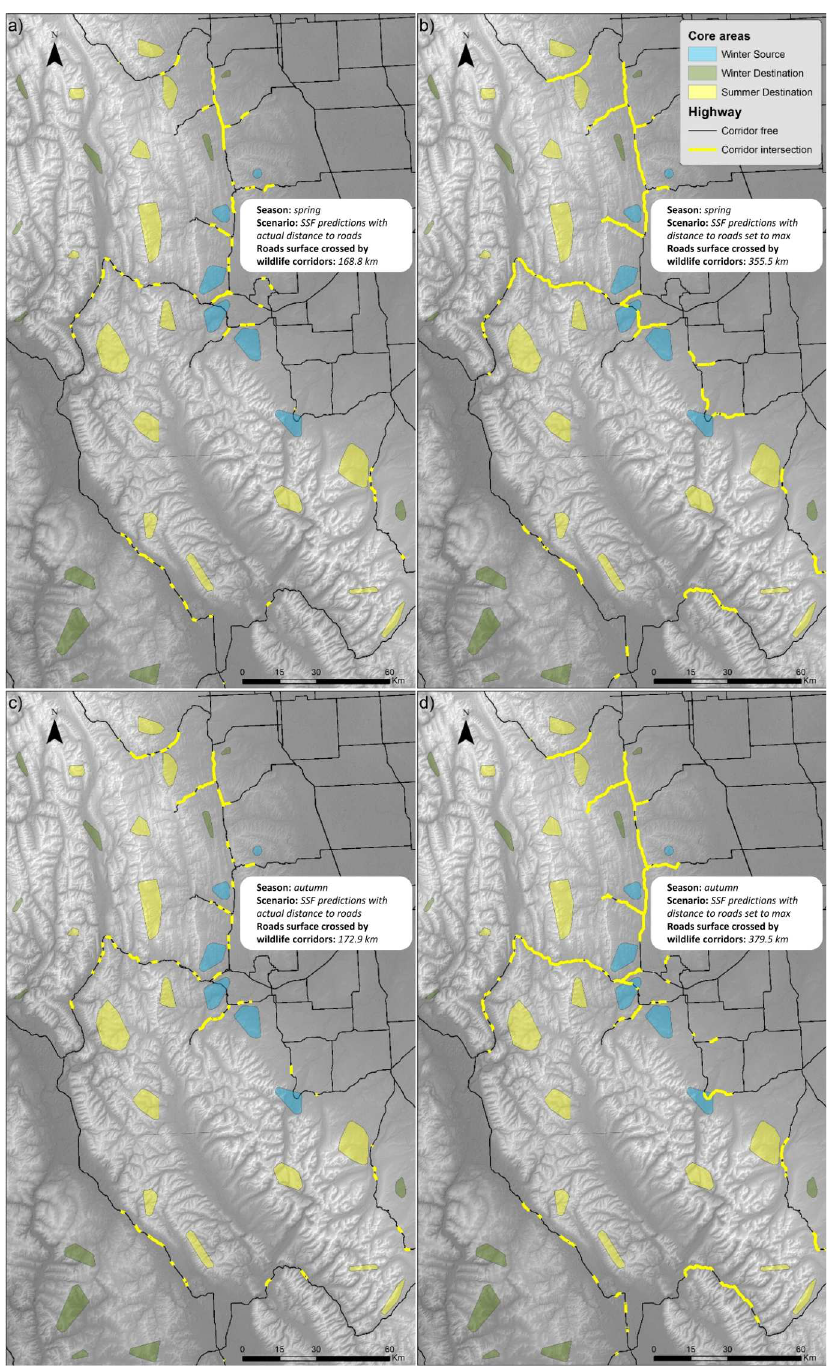
Fig 6. Corridor-road intersections of a) 168.8 km in spring considering SSFs predictionscomputed with actual distance to roads, b) 355.5 km in spring assumingas there were no roads (i.e., distance to roads set to maximum value when predictingSSFs), c) 172.9 km in autumn considering roads, and d) 379.5 km in autumn assuming as there were no roads. Maps b) and d) depict road segments that would be crossed by elk if there were no roads. About half of these segments are predicted not to be crossed by elk (maps a, c) as a result of road avoidanceby